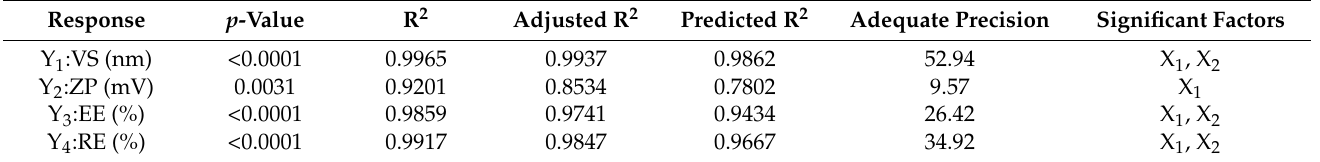
Table 3. Output data analysis of the 4 1 3 1 factorial design used for the formulation of RLX-EMLs.